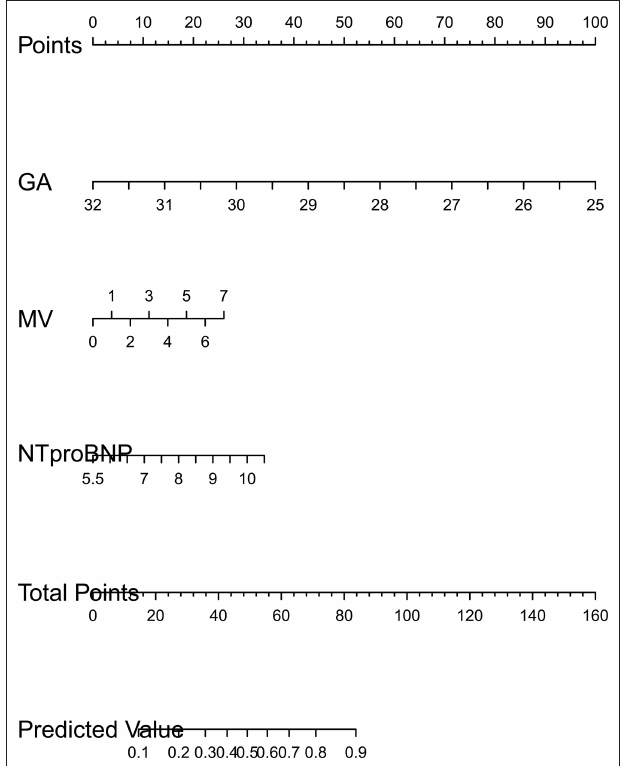
FIGURE 2 | Developed BPD nomogram. GA is gestational age. MV is the time of mechanical ventilation in the 1st week. NTproBNP is the logarithm of NT-pro BNP level based on e. The usage of nomogram. Mark the value of factors on the corresponding axis and draw a vertical line passing the marked point to obtain the corresponding points. Then, we obtain the points together and mark the total points on the “total point” axis. Draw a vertical line passing the marked point and mark where the line crosses the axis of “probability” to read out the